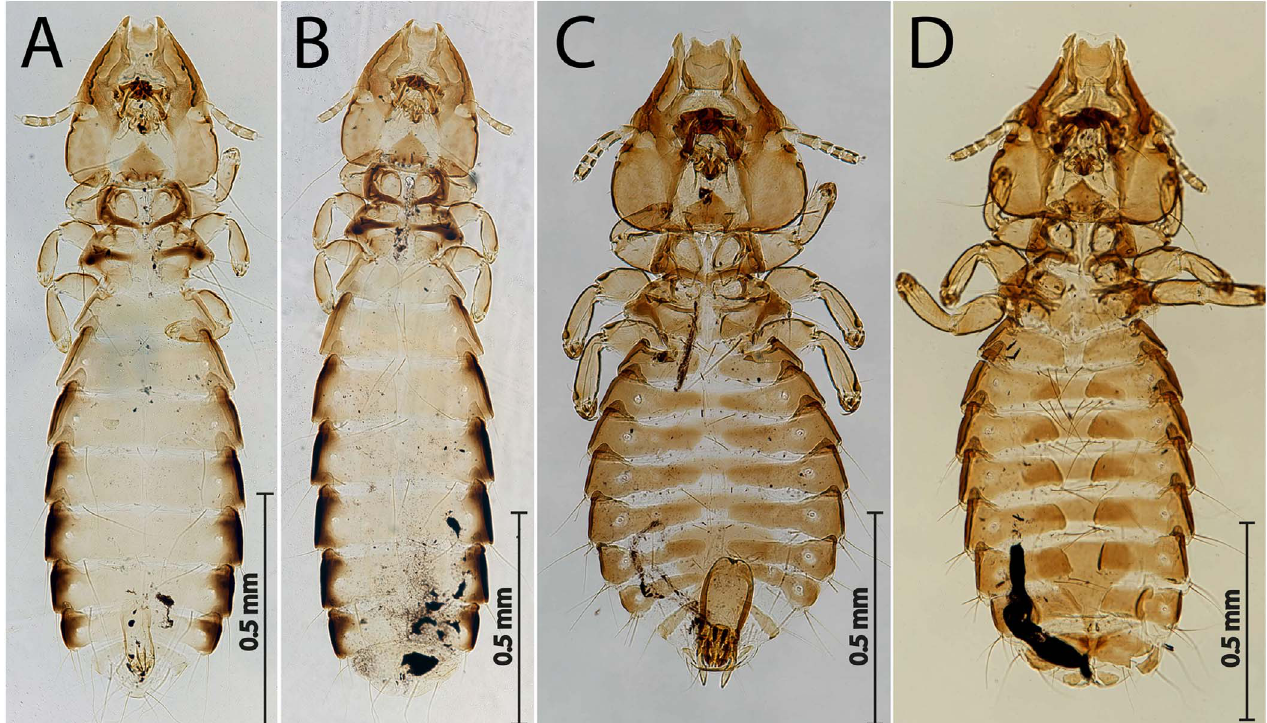
Figure 5. Habitus: Guimaraesiella tovornikae ex Sylvia atricapilla . (A) Holotype male; (B) Paratype female. Sturnidoecus ex Turdus merula; (C) Male; (D)